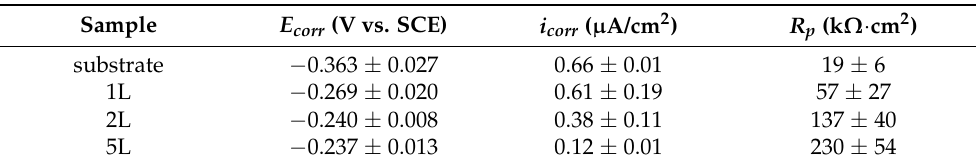
Table 2. Corrosion potential ( E corr ), corrosion current densities ( i corr ), and LPR polarization resistance ( R p ) measured for all samples in a 3.5 wt.% NaCl solution (n = 3).